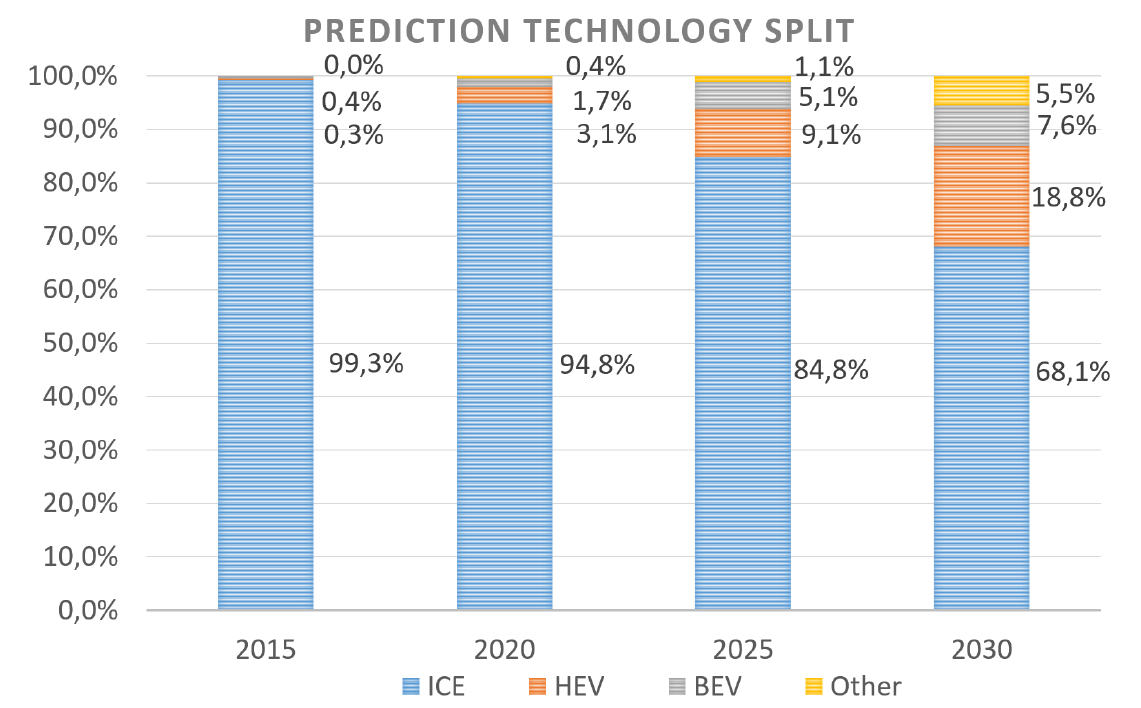
Figure 1. Evolution of the technology split between electric vehicles ( EV ), hybrid electric vehicles ( HEV ), internal combustion engines ( ICE ) and other up to 2030.